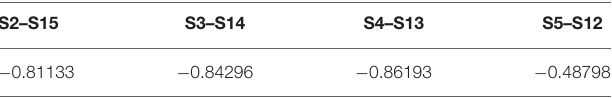
TABLE 3 | Correlation between sensors at the top and bottom when the train is on the selected span.